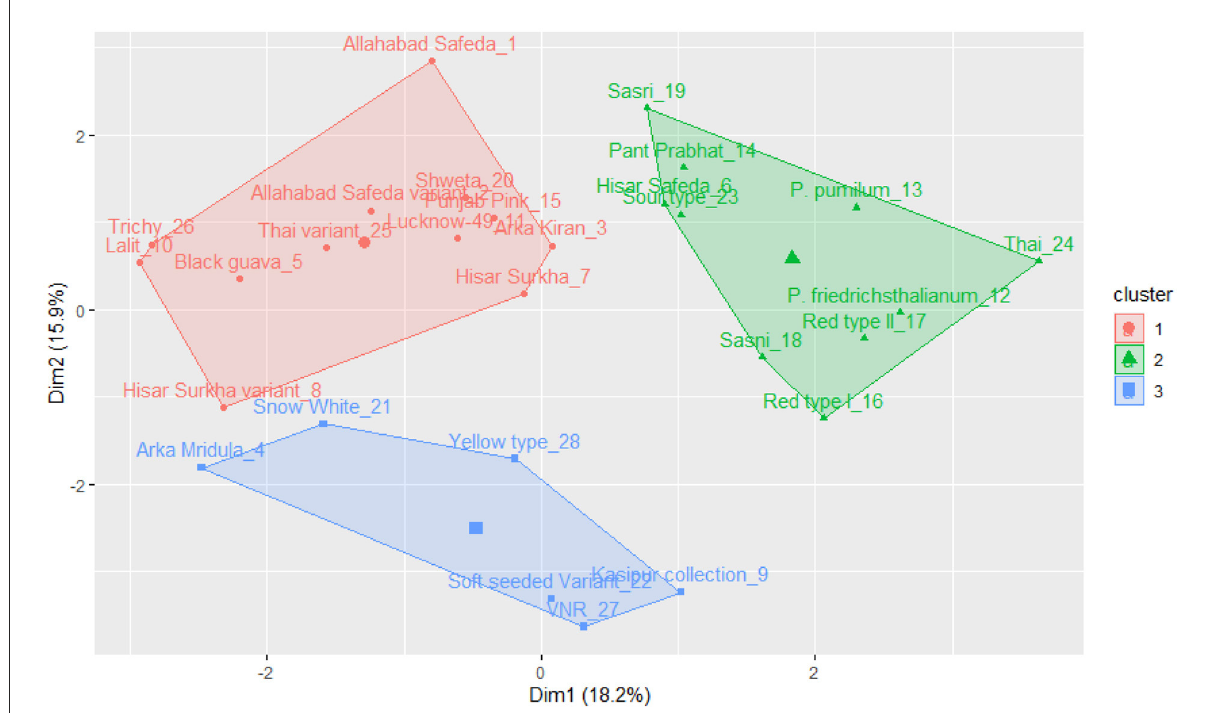
FIGURE3 K-means cluster solutions plotted against the PCA scatter plot (component 1 on the X axis and component 2 on the Y axis, k-3) based on the 17 qualitative traits.